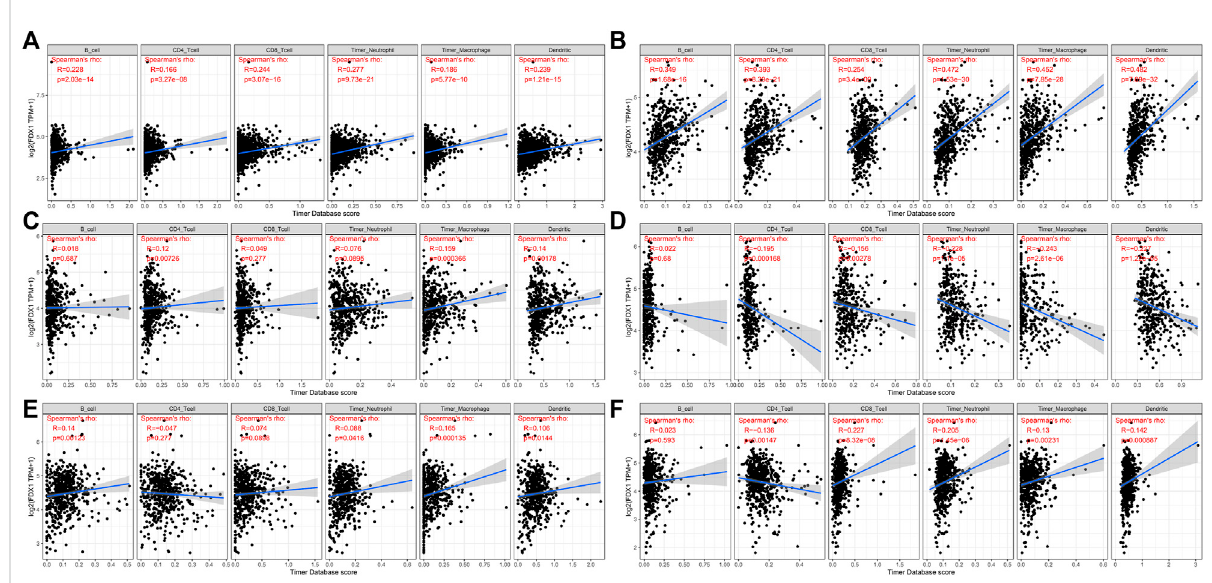
FIGURE 7 Correlation of six immune cell (B cells, CD4 + T cells, CD8 + T cells, neutrophils, macrophages, and dendritic cells) in fi ltration scores with FDX1 mRNA expression in six kinds of cancer [ (A) : BRCA, (B) : IGG, (C) : HNSC, (D) : STAD, (E) : KIRC, and (F) : UCEC]. Spearman correlation test, p < 0.05 was signi fi